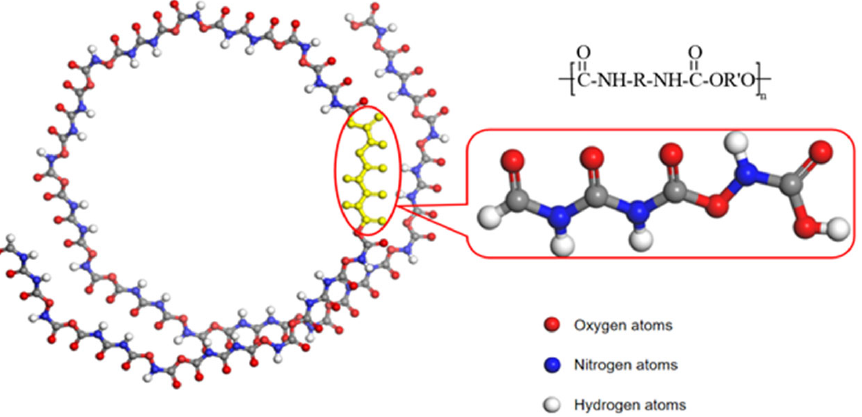
Figure 2. Molecular structure of polyurethane.